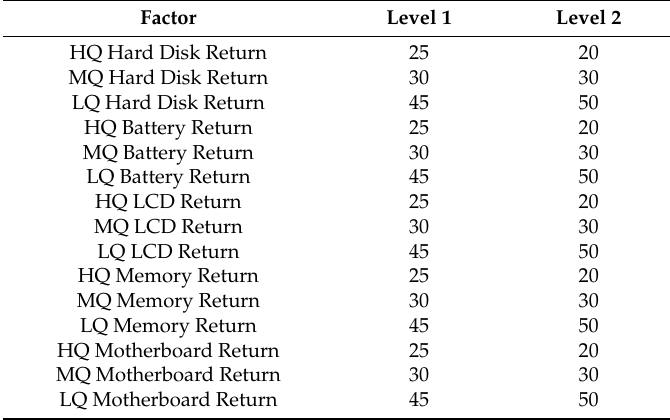
Table 6. Quality level probabilities when renewal-time threshold is exceeded